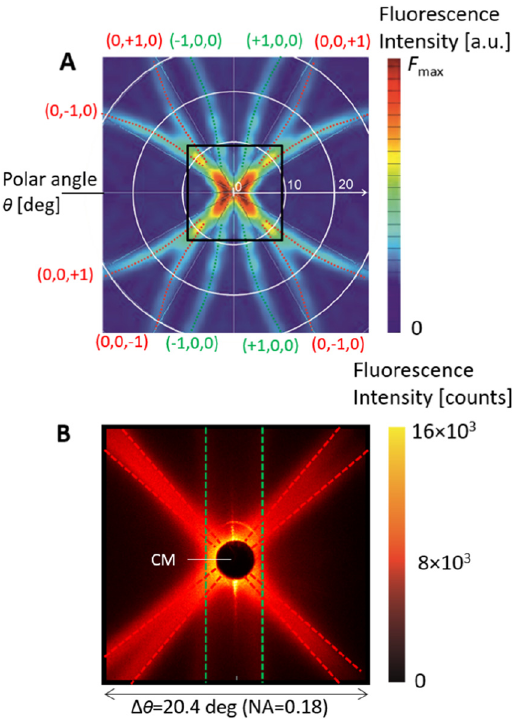
Figure 4: Surface plasmon-coupled emission at λ em